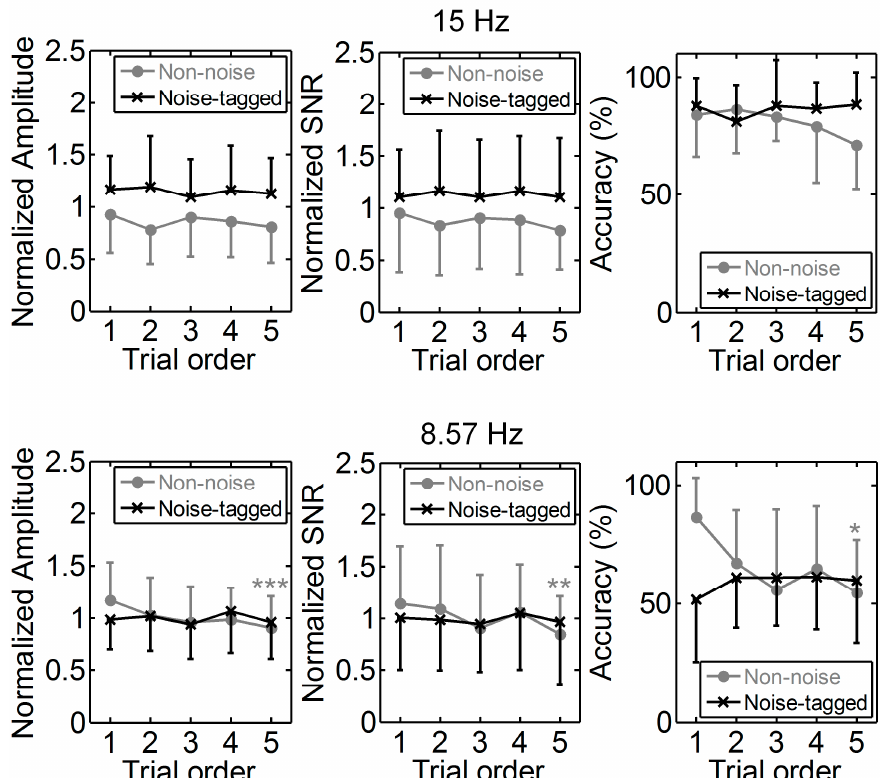
Figure 6. Comparison of fatigue indices of normalized amplitude, SNR, and online accuracy between five consecutive on-task trials in both non-noise and noise-tagged BCI tasks across participants. The grand-averaged mean values and SD of amplitude, SNR, and accuracy were calculated from five consecutive trials of the same order in each run across twelve participants. All statistics were assessed by one-way ANOVA, * p < 0.05 between five consecutive trials in both non-noise and noise-tagged tasks, ** p < 0.01 between five consecutive trials, *** p < 0.001 between five consecutive trials.